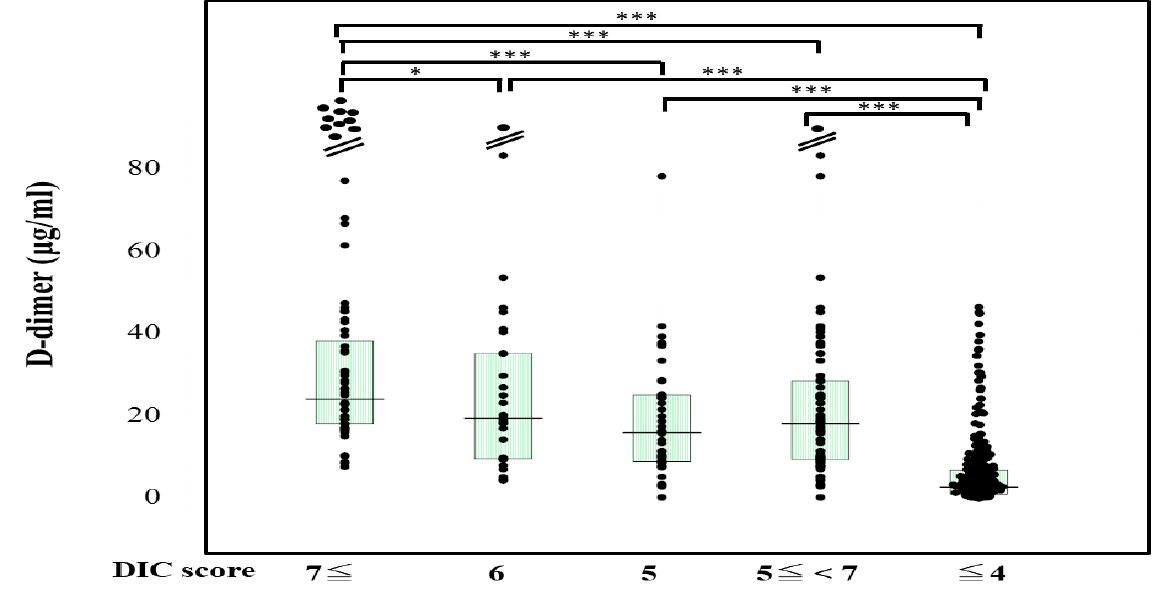
Figure 2. D-dimer levels in patients with DIC, those with pre-DIC and those without DIC. DIC, DIC score ≥ 7; pre-DIC, DIC score 5 or 6; without DIC, DIC score ≤ 4; * p < 0.05; *** p < 0.001.